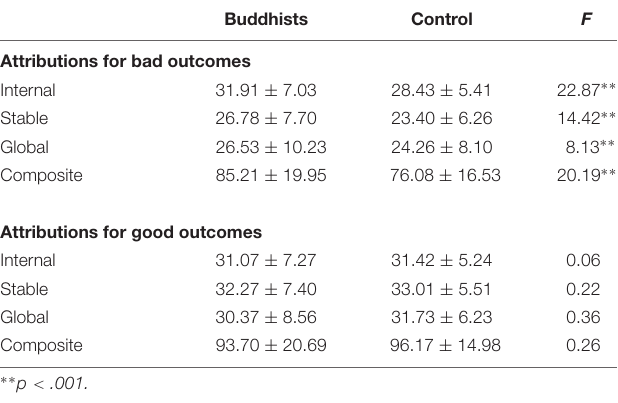
TABLE 2 | Comparisons between the Buddhist and control groups on attributional styles. Buddhists Attributions for bad outcomes